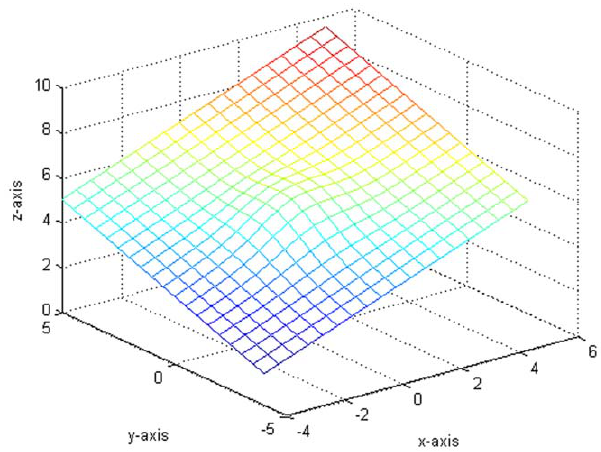
, b , and b of GLS and 0 1 2